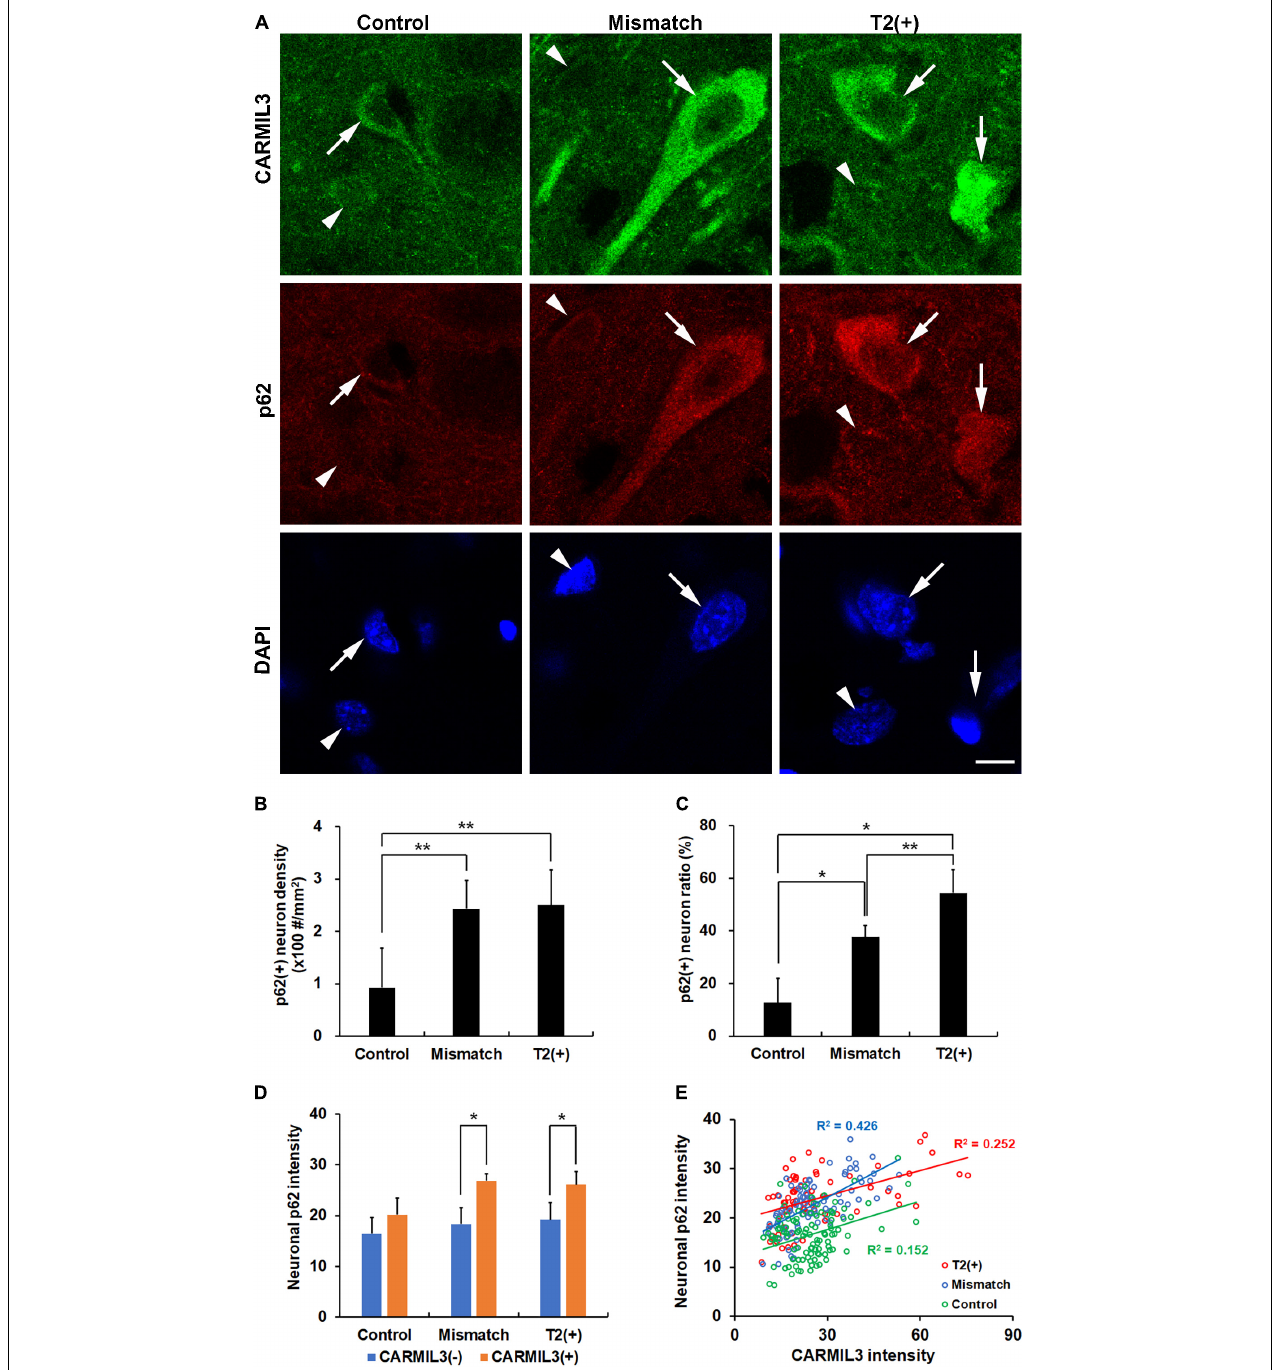
FIGURE 7 | Association of CARMIL3 with impaired autophagy. (A) Immunostaining results of CARMIL3 and p62, an autophagy marker, in the T2(+), mismatch, and control areas. CARMIL3(+) neurons (arrows) were characterized by high expression of p62 compared with CARMIL3( − ) neurons (arrowheads) in the T2(+) and mismatch regions. (B,C) p62(+) neuron densities (B) and ratios (C) in the three regions. The p62(+) neuron densities were significantly different among the three regions (p = 0.004), with a similar pattern in p62(+) neuron ratios [the number of p62(+) neurons divided by total number of neurons] (p = 0.018). The p62(+) neuronal densities and ratios in the mismatch and T2(+) regions were higher than those in the control areas (all p < 0.05). (D) Neuronal p62 intensity in CARMIL3(+) and CARMIL3( − ) neurons in the three regions. CARMIL3(+) neurons had significantly higher p62 intensity than CARMIL3( − ) neurons in the T2(+) and mismatch regions (both p < 0.05). (E) Correlation of p62 intensity with CARMIL3 intensity of all neurons in one image of each region in four rats. There was a significant association between p62 and CARMIL3 intensities in each region (all p < 0.001). In addition, there were significant differences in the regression slopes between the T2(+) and mismatch regions ( p = 0.004) and between the mismatch and control regions ( p = 0.017). * p < 0.05; ** p < 0.01. Scale bar = 10 µ m.